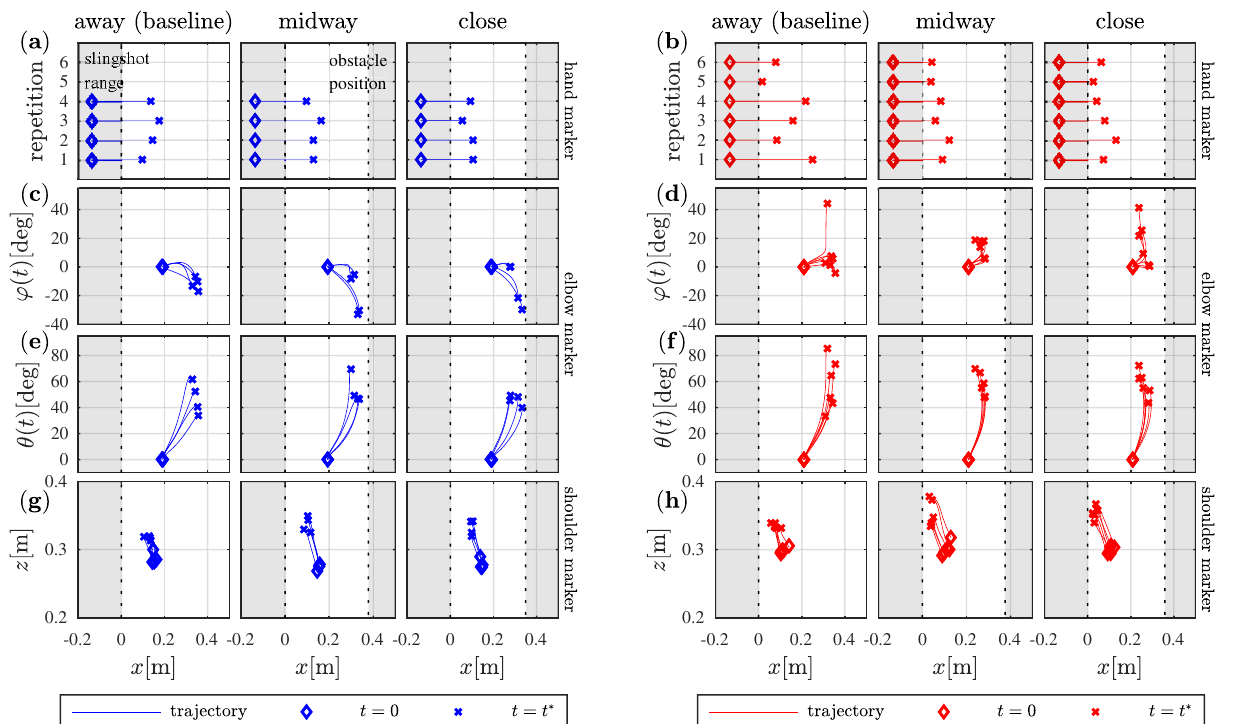
Figure 2. Raw data of representative subjects from each group. ( a , b ) Trajectories of hand marker ( x -coordinate) for all trials of one representative subject from each group. ( c , d ) Lateral elbow displacement ϕ( t ) over x -coordinate values of the elbow marker for all trials of one representative subject from each group. ( e , f ) Upward elbow displacement θ( t ) over x -coordinate values of the elbow marker for all trials of one representative subject from each group. ( g , h ) Cartesian trajectories of shoulder marker in xz -plane. The definition of ϕ( t ) , θ( t ) and the right-handed coordinate system are depicted in Fig. 6c.